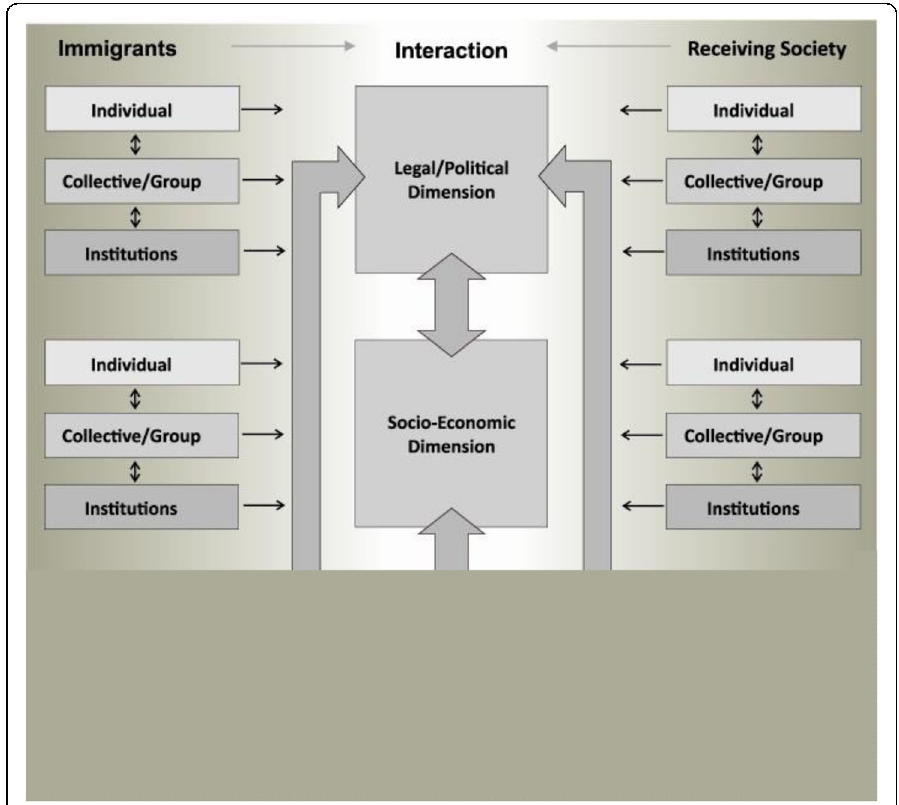
Fig. 1 A heuristic model for the empirical study of integration processes. Source: Penninx & Garcés – Mascareñas (2016, p.